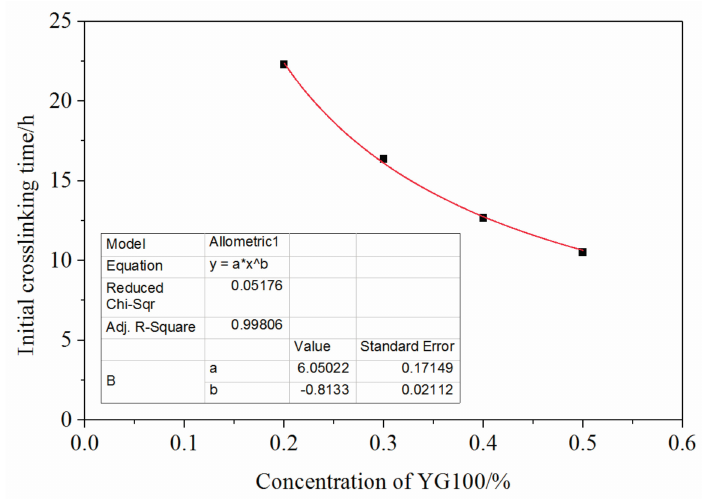
Figure 6. Polymer concentration effect on initial gelation time of the polymer